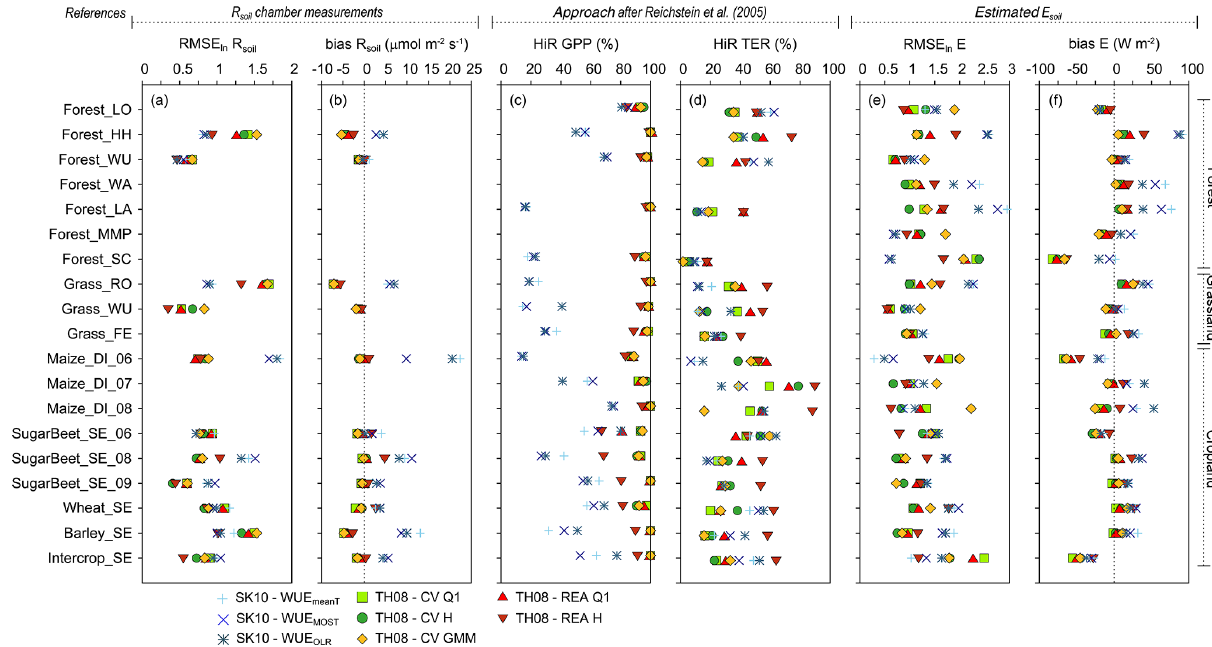
Figure 6. Error metrics for source partitioning results for each study site and method version (see text for description). (a–b) Root mean square error in log-transformed data (RMSE ln ) and bias considering soil respiration ( R soil ) chamber measurements, (c–d) percent fraction of time steps with partitioning results in the range (HiR) of estimated gross primary production (GPP) and total ecosystem respiration (TER) by the approach after Reichstein et al. (2005), and (e–f) RMSE ln and bias considering soil evaporation ( E soil ) estimated based on Beer’s